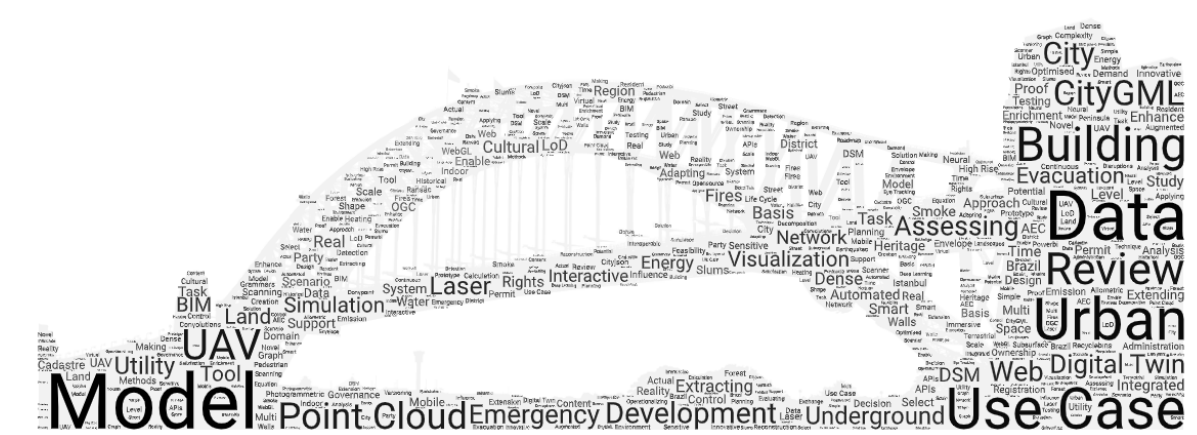
Figure 1: Visualisation of keywords in the shape of Sydney Harbour Bridge, Sydney, NSW,